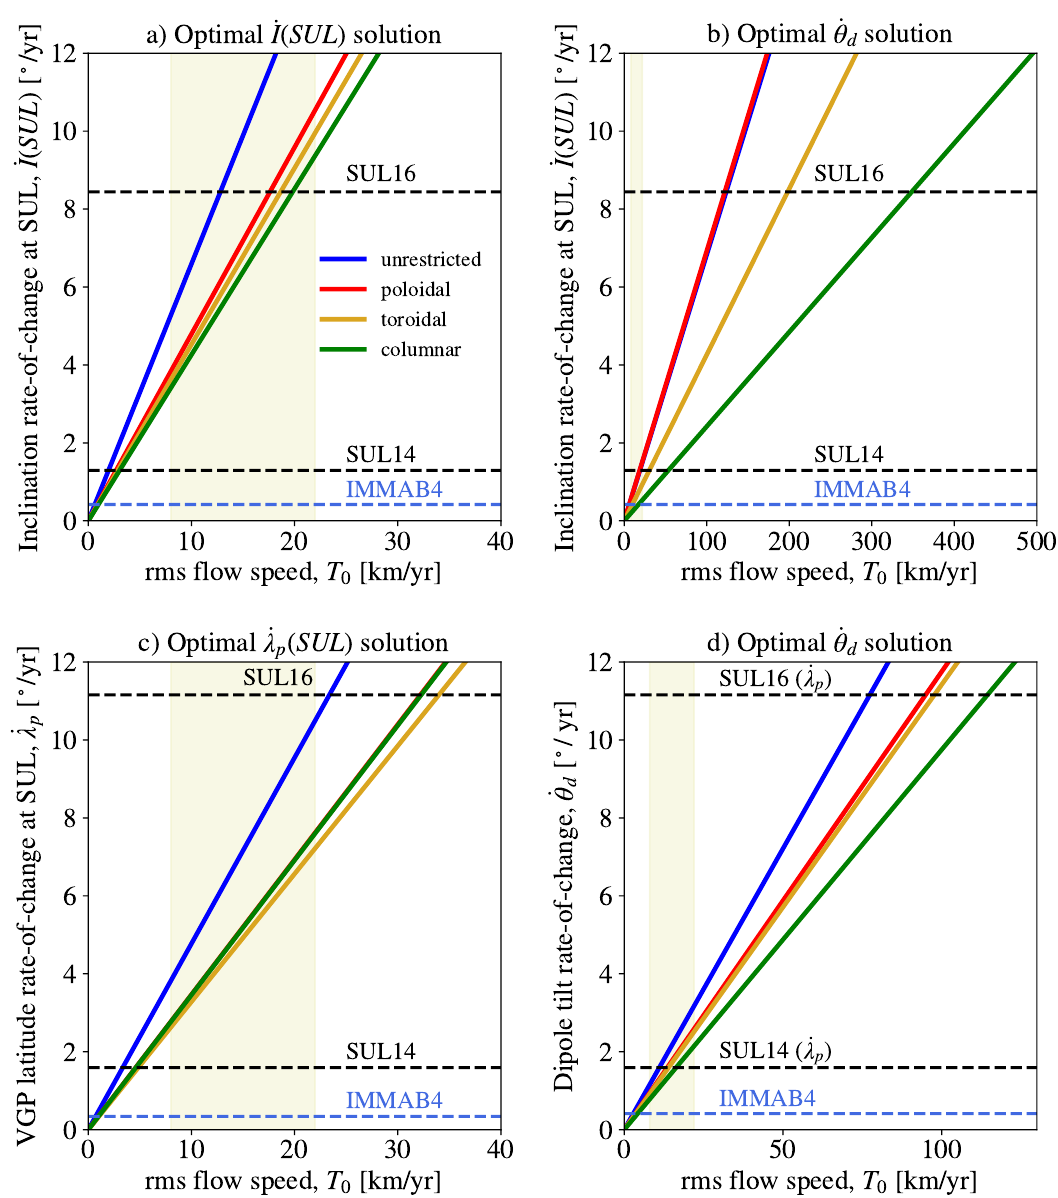
Figure 9. Maximum optimal values of ˙ I ( SUL ) ( a ), ˙ I ( SUL ) calculated from the flow producing the maximum optimal ˙ θ d ( b ), and maximum optimal values of ˙ λ P ( SUL ) ( c ) and ˙ θ d ( d ), for flow restrictions indicated in the legend. In ( b ), the red and blue lines are partially superimposed, and in ( c ), the red and green lines are visually superimposed. The dashed, black lines labelled “SUL14” and “SUL16” report values from, respectively, [13,14] during the M-B transition. The black horizontal lines indicated by “SUL14(˙ λ p )” and “SUL16(˙ λ p )” in ( d ) are the same as in ( c ). The light blue, dashed line labelled “IMMAB4” indicates the maximum rates of change from the IMMAB4 model. The shaded area indicates estimates of CMB flow speed rms values between 1840 and the present day (see [43] and the references therein). Note that the horizontal scale is not the same for all